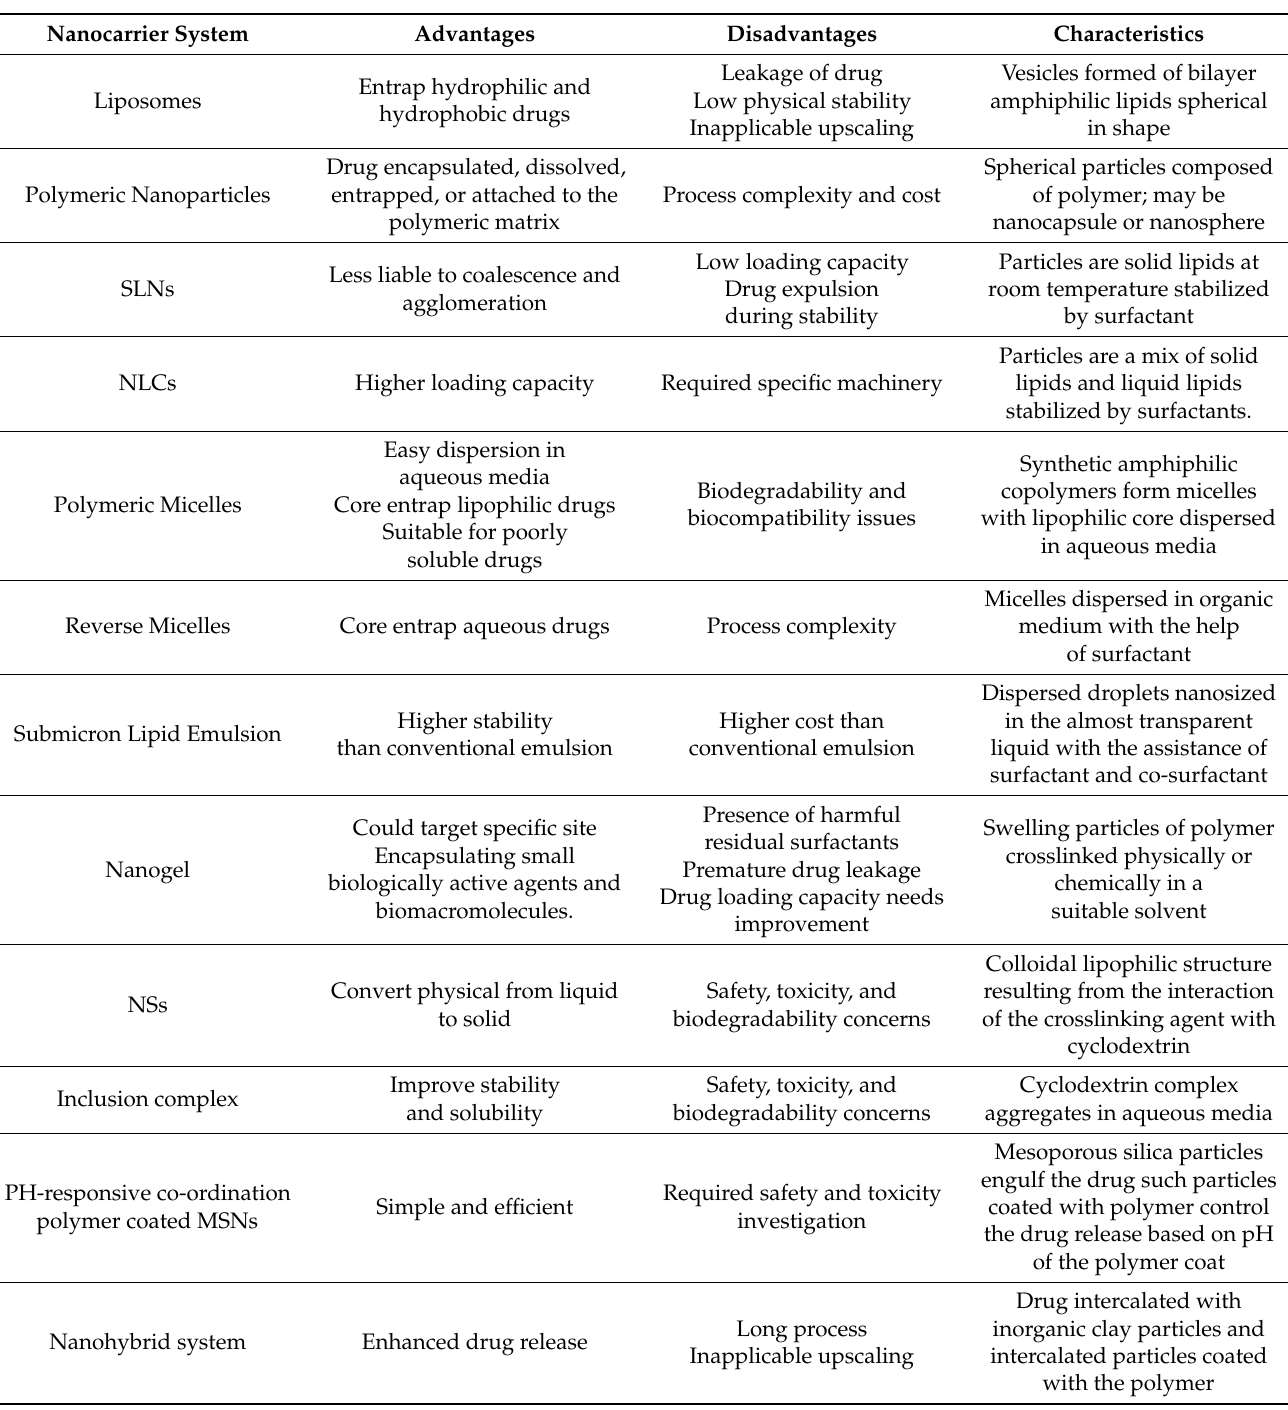
Table 3. Advantages, disadvantages, and characteristics of nanocarrier systems in taste